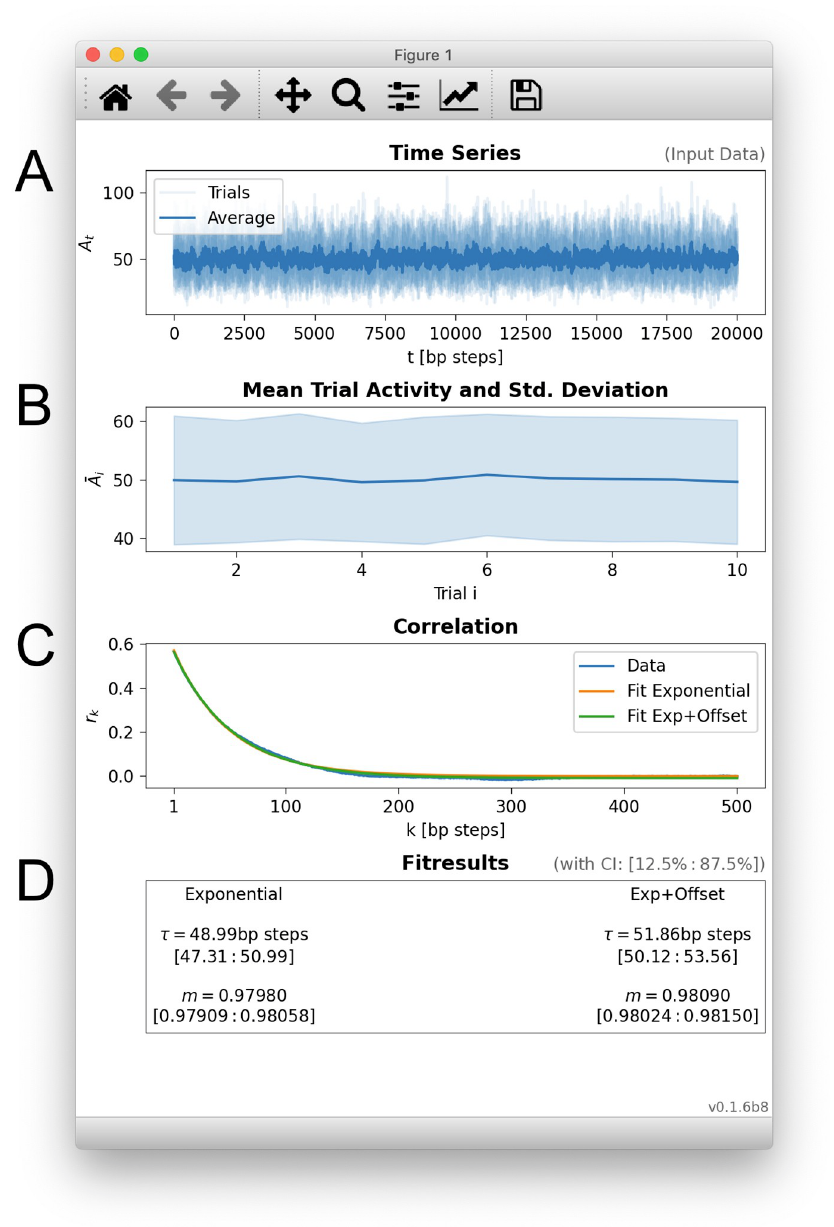
Fig 1. The toolbox provides a full_analysis() function that performs all required steps and produces an overview panel. A : Time series of the input data, here the activity A t of ten trials of a branching process with m = 0.98 and τ = Δ t /ln( m ) � 49.5 steps ( Δ t is the step size of the branching process). B : Mean activity and standard deviation of activity for each trial. This display can reveal systematic drifts or changes across trials. C : Correlation coefficients r k are determined from the input data, and exponentially decaying autocorrelation functions are fitted to the r alternative fit functions can be chosen. D : The decay time of the autocorrelation function corresponds to the intrinsic timescale τ , and allows to infer the corresponding branching parameter m . The shown fit results contain confidence intervals in square brackets (75% by default).